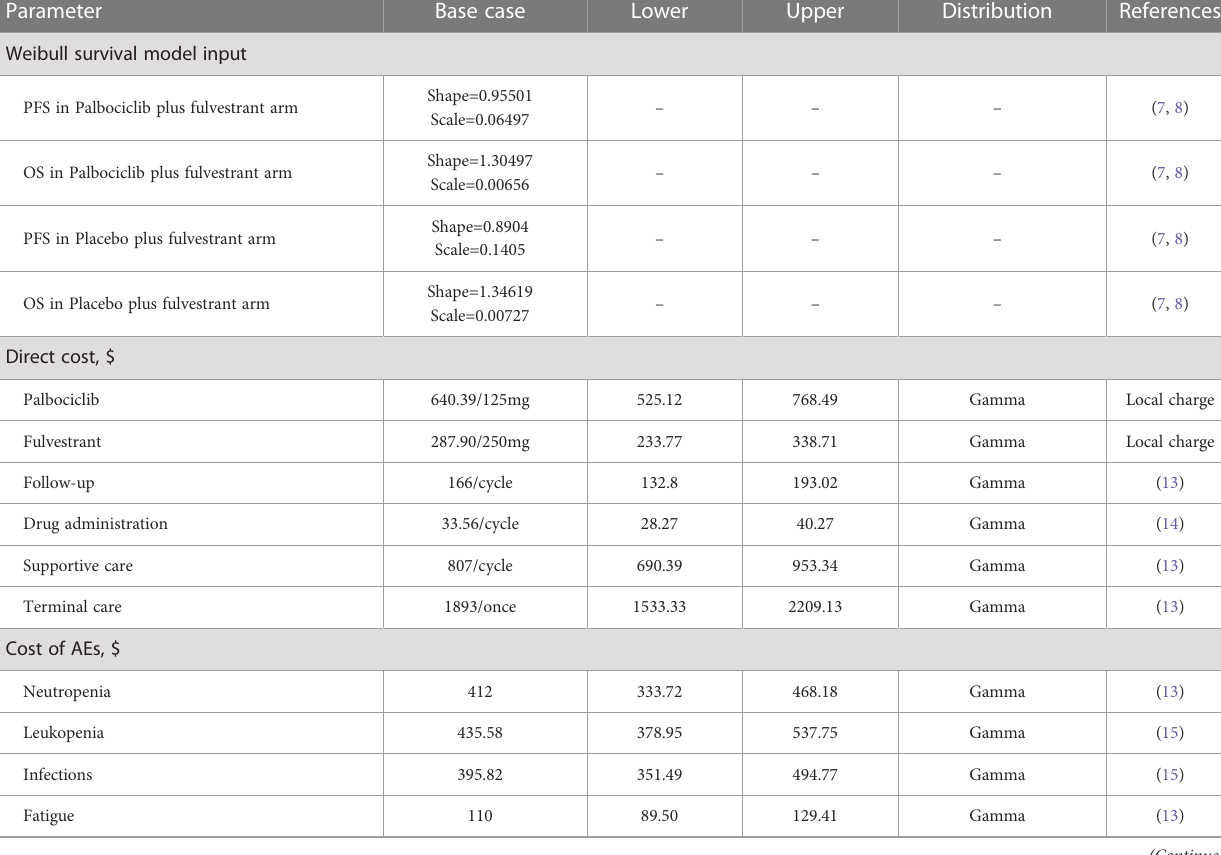
TABLE 1 Model parameters. Parameter Base